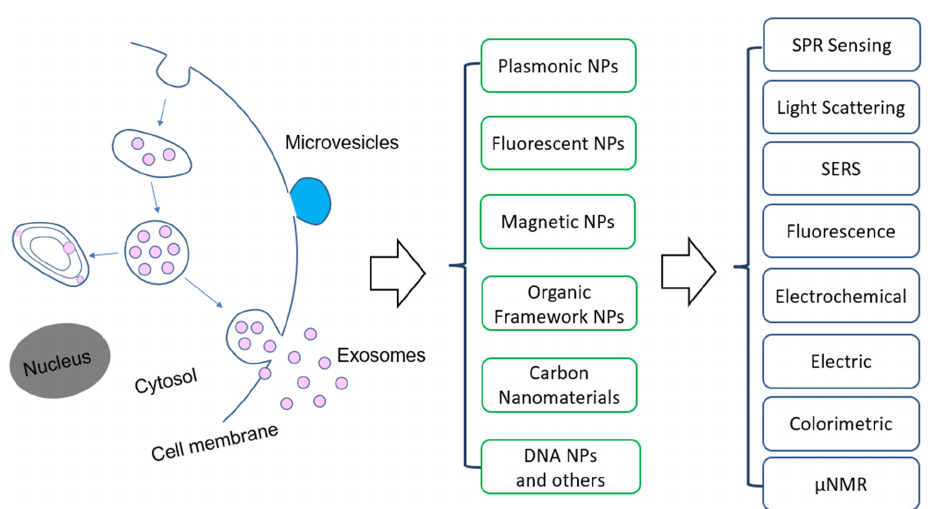
Figure 1. Overview of the application of nanomaterials and detection methods for extracellular ves- icles. Abbreviation: NPs − nanoparticles, SPR − surface plasmon resonance, SERS − surface enhanced Raman scattering, µNMR: micro − nuclear magnetic resonance. cles. Abbreviation: NPs—nanoparticles, SPR—surface plasmon resonance, SERS—surface enhanced Raman scattering, µ NMR: micro-nuclear magnetic